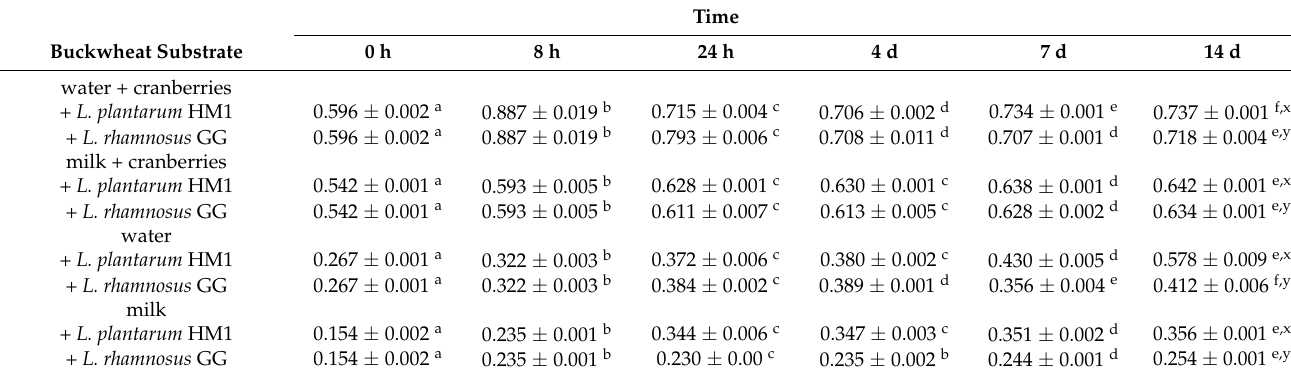
Table 2. Total phenolic content of buckwheat mashes (mg GAE/g).